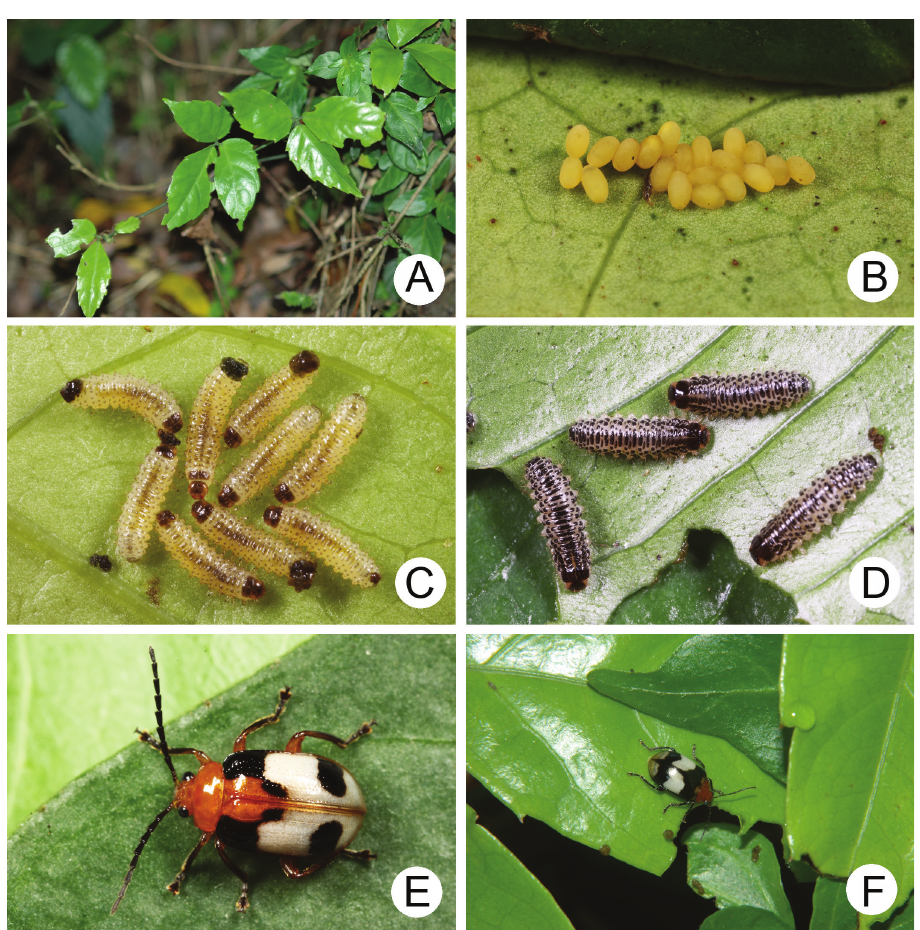
Figures 11. Field photographs of Gallerucida sauteri Chûjô. A Host plant: Tetrastigma formosanum B Egg mass C Early instar larvae D Mature larvae E Adult, typical form F Adult, color variation.